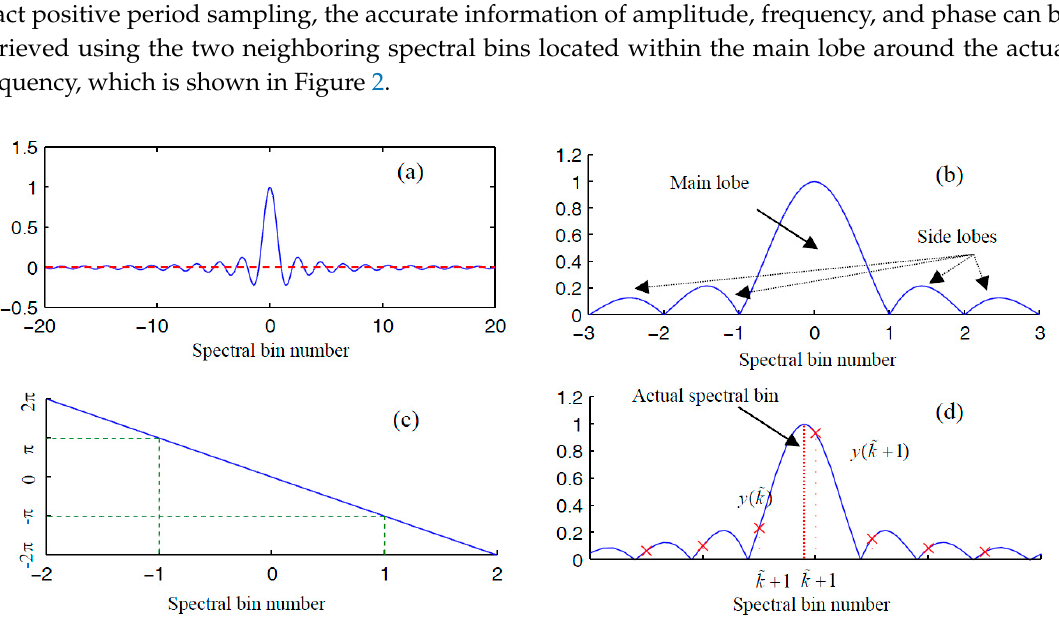
Figure 2. Fundamental principles of a rectangular-window-based spectral correction method. ( a ) The magnitude response; ( b ) zoomed-in plot of the magnitude response; ( c ) the phase response; and ( d ) the FFT grids compared with the magnitude response.